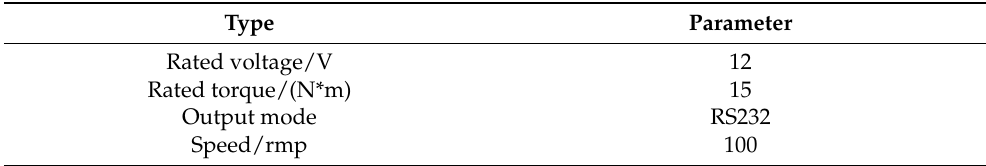
Figure 1. Installation schematic diagram of steering wheel-like motor. ( a ) Structure diagram. ( b ) Installation drawing: 1. Steering wheel; 2. Tight set; 3. Barrel motor; 4. Fixed axle support; 5. Locking bolt; 6. Fixed shaft. Table 1. Parameters of steering wheel-like